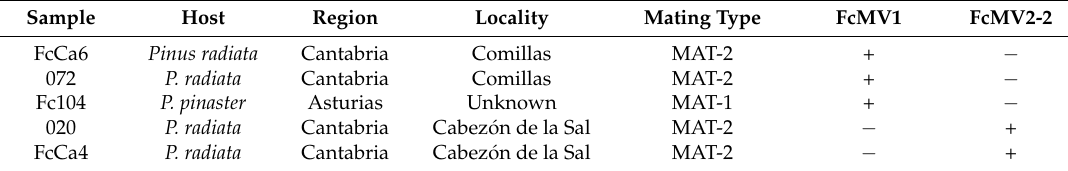
Table 1. Virus positive isolates of F. circinatum used to obtain single-spore cultures. Isolate, code; Host, from which the sample was isolated; Region and Locality (village); Mating type, MAT-1 or